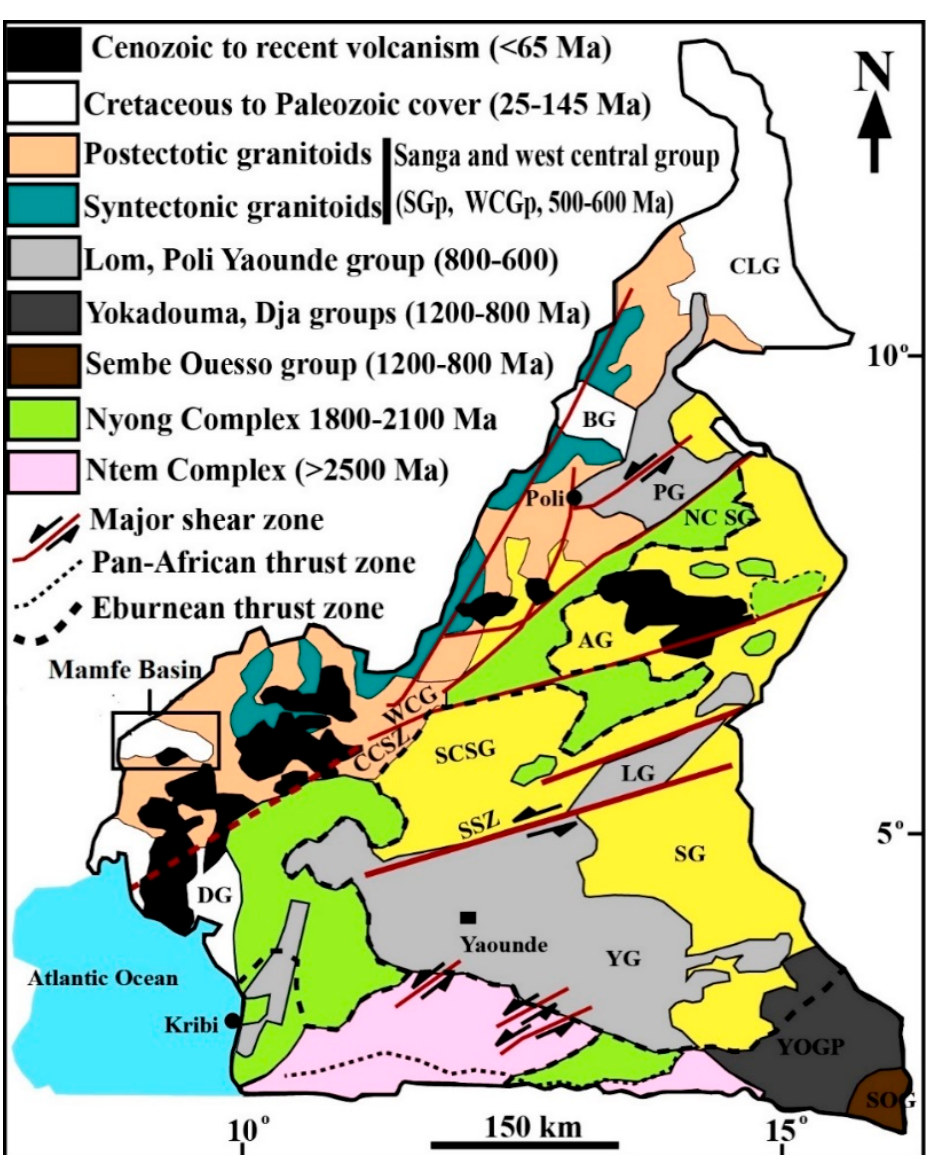
Figure 1. Sketched geological map of Cameroon (adapted from [101]). Oubanguide Complex: NCSG: Northern Cameroon SGp (PG: Poli Group, AG: Adamawa Group, WCG: West Cameroon Group); SCSG: Southern Cameroon SGp (YG: Yaoundé Group, LG: Lom Group, SG: Sanaga Group); SECSGp: Southeastern Cameroon SGp (DG: Dja, YoGroup: Yokadouma, S.O.Group: Sembe Ouesso Group); CCSZ: Centre Cameroon shear zone; SSZ: Sanaga shear zone; Sedimentary cover: (CLG: Chad Lake Group; BG: Benue Group; MG: Manfe Group; DG: Douala Group); B: Cameroon main lithostructural units).